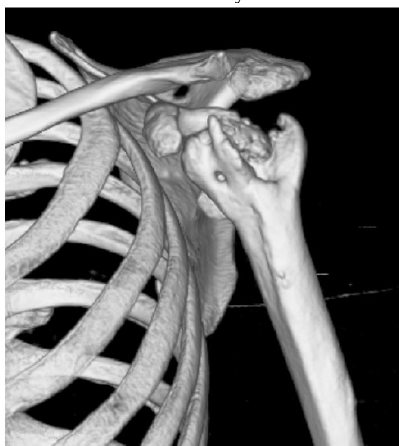
Figure 3 . CT reconstruction confirmed the humeral head collapse with sparing of the acromion.